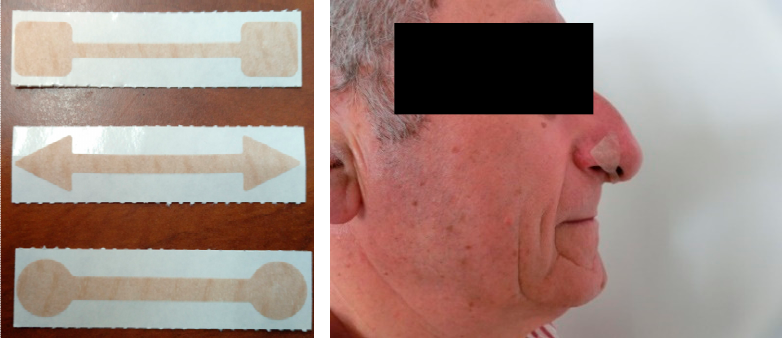
Figure 1. Three different sizes of the FeelBreathe ® device: 4, 5 and 6 mm. FeelBreathe ® device placed under the nostrils.